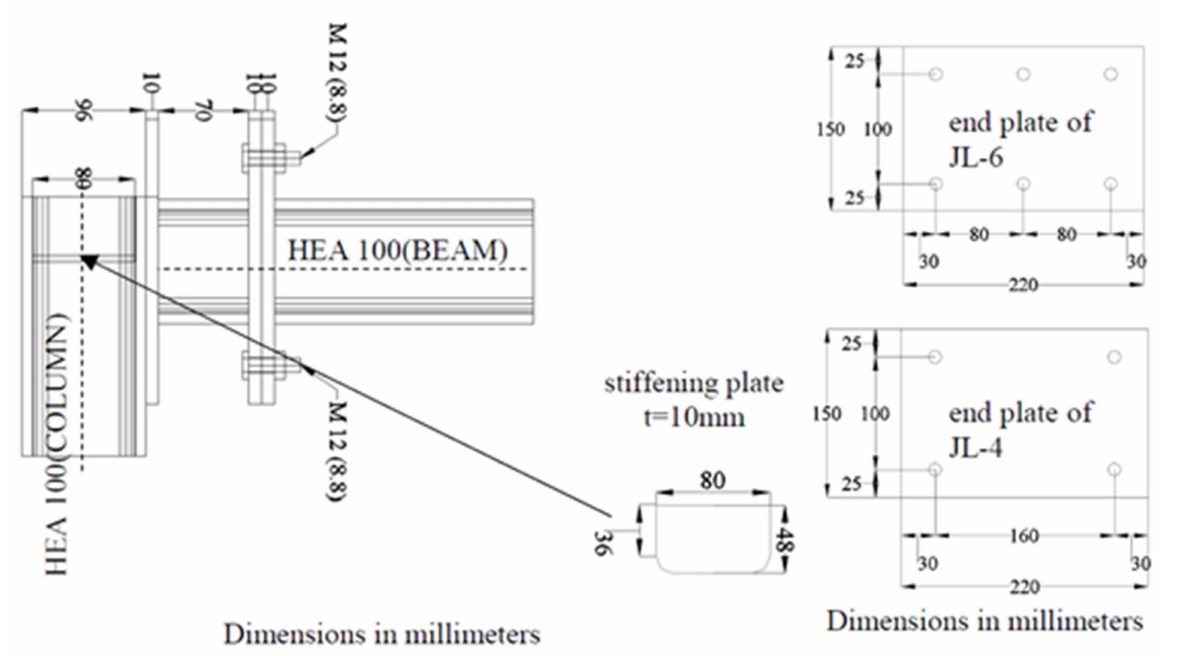
Figure 13. Two-dimensional schematic view of JL-4 bolted steel joint specimen configuration with geometrical details of the steel connecting plates of the JL-4 and JL-6